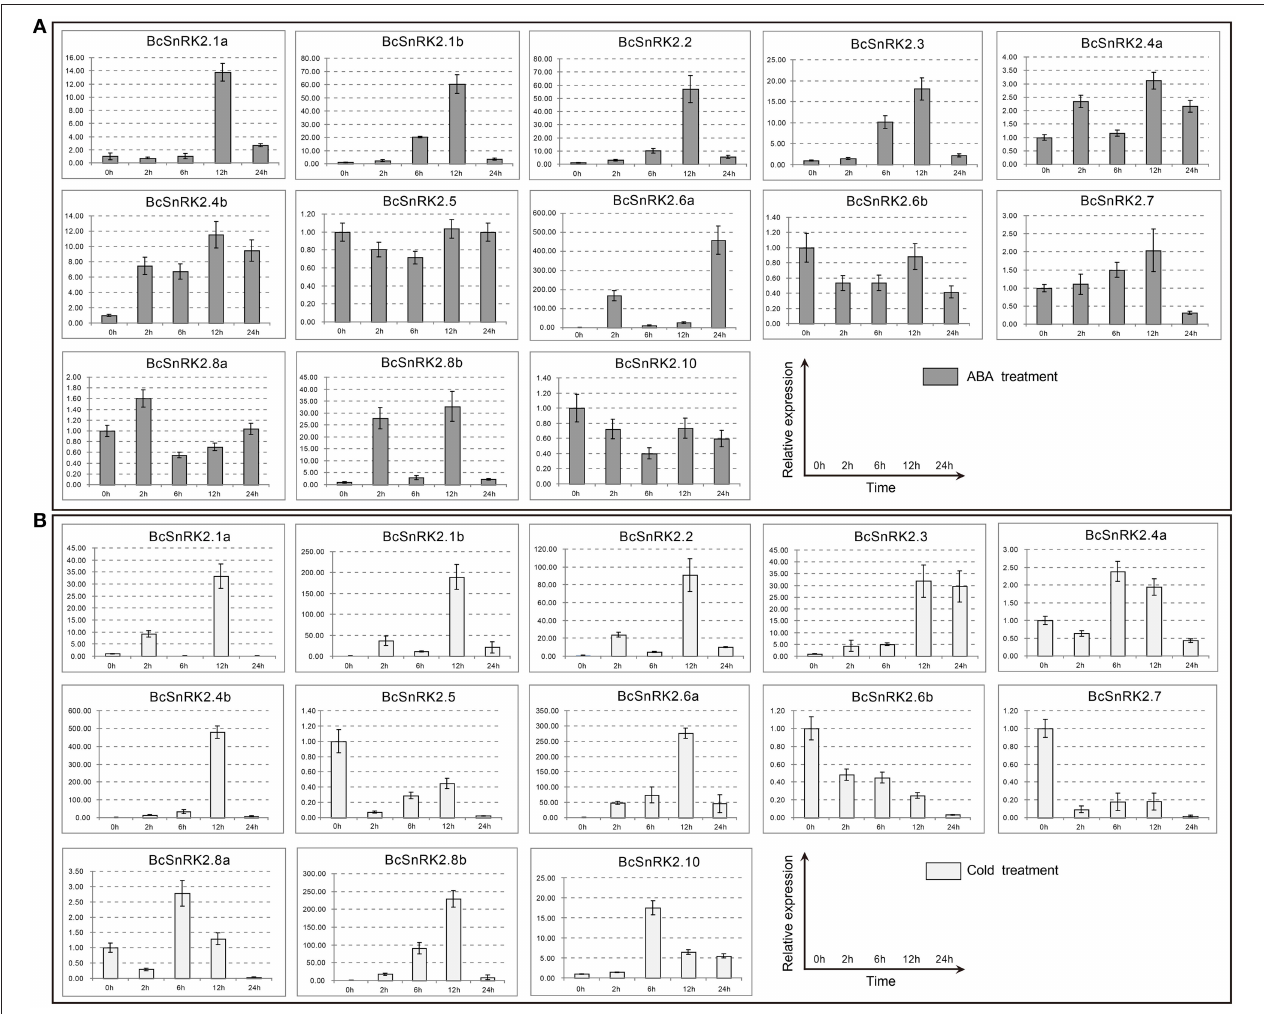
FIGURE 7 | Expression patterns of the 13 BcSnRK2s under ABA and cold treatments. Pak-choi plants were subjected to ABA (A) and cold treatments (B) . The 13 stress-inducible BcSnRK2s were differently expressed in the leaves in response to abiotic stressors and their transcript levels were quantified against BcGAPDH transcript levels using 2 − 11 CT , 11 CT = 1 CT (treated sample) − 1 CT (untreated sample), 1 CT = CT target -CT BcGAPDH